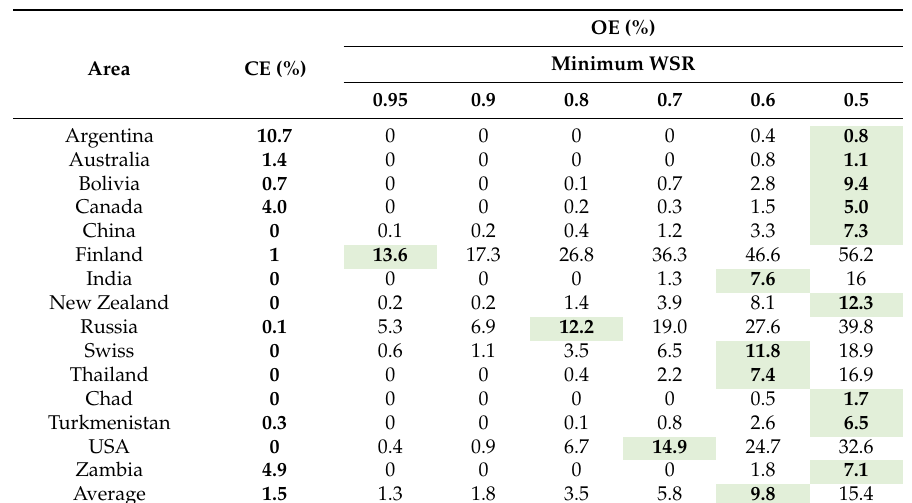
Table 1. Assessment results for the 15 test areas. The user requirements define a maximum omission and commission error of 15%. All commission errors fall within the requirements. The acceptable omission errors for the highest WSR are